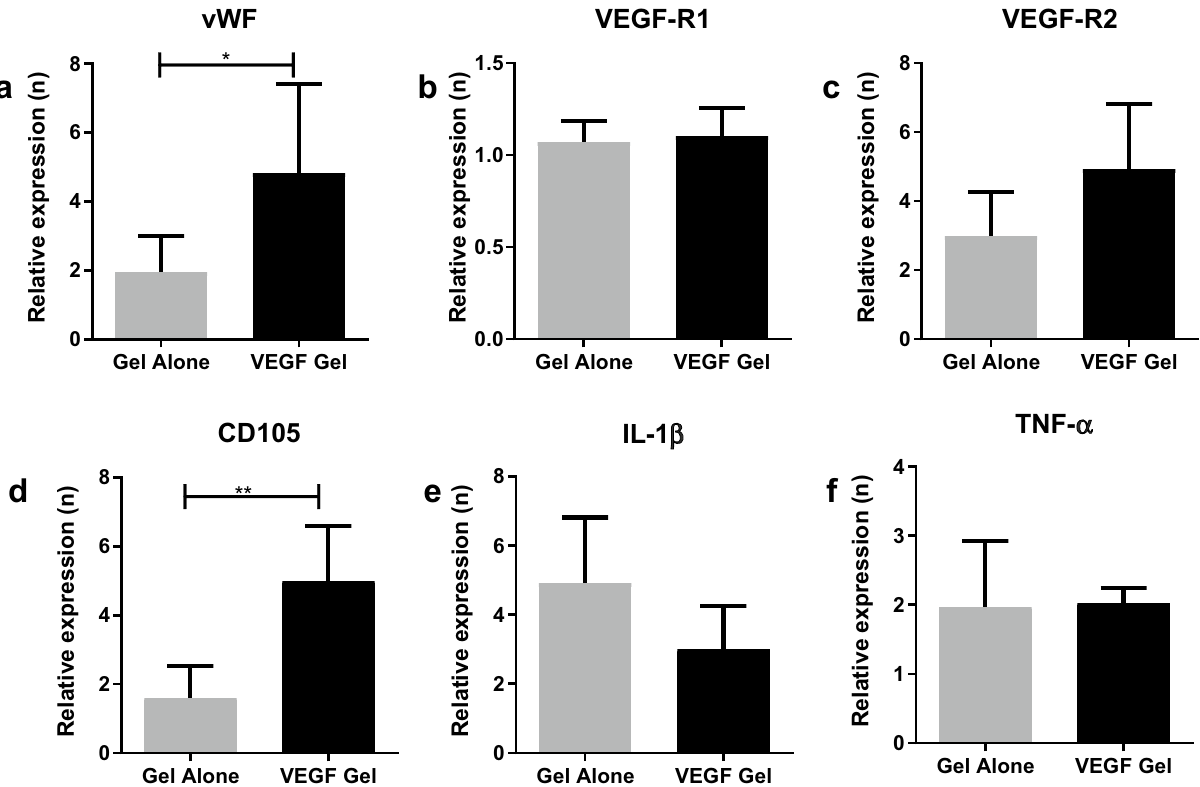
Figure 6. Relative gene expression within the peri-lesion (defect) soft tissue normalized to no-gel levels; vWF ( a ), VEGF-R1 ( b ), VEGF-R2 ( c ), CD105 ( d ), IL-1β ( e ), and TNF-α ( f ) (**p < 0.01, *p <